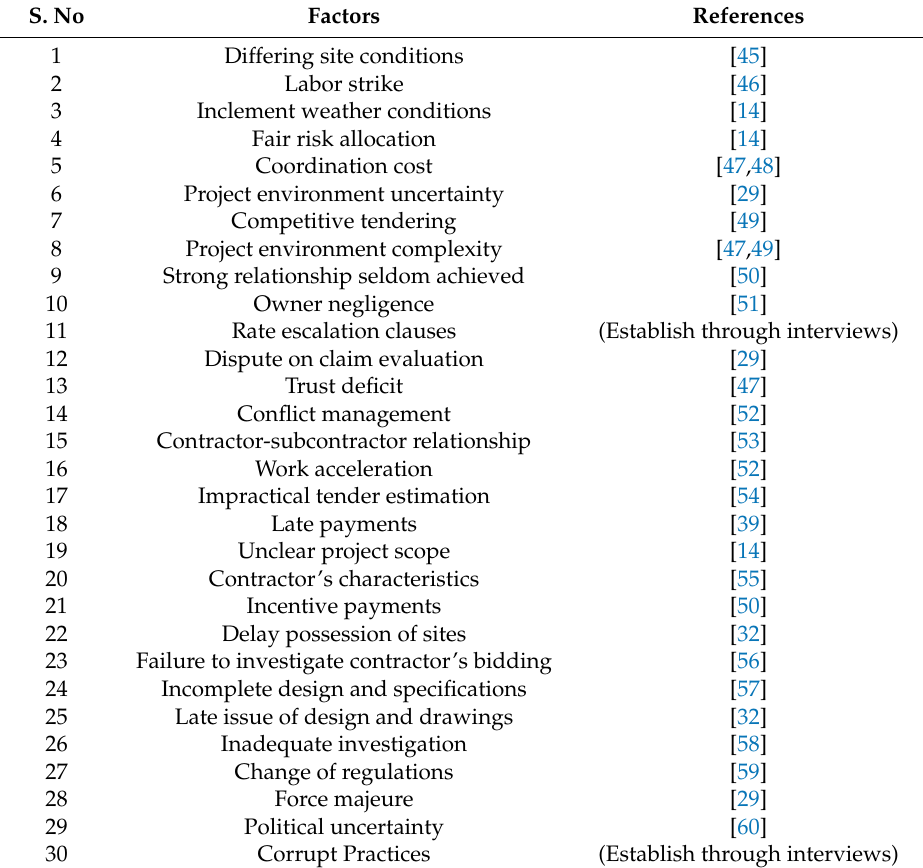
Table 1. The Summary of Uncertainty Factors that Escalate Transaction